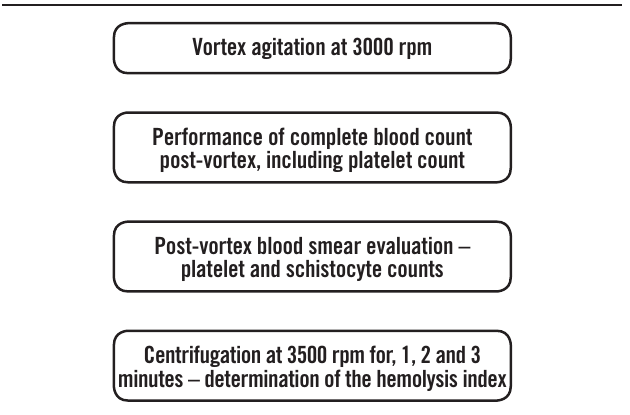
figurE − Flowchart showing methodological aspects of the experiment rpm: revolutions per